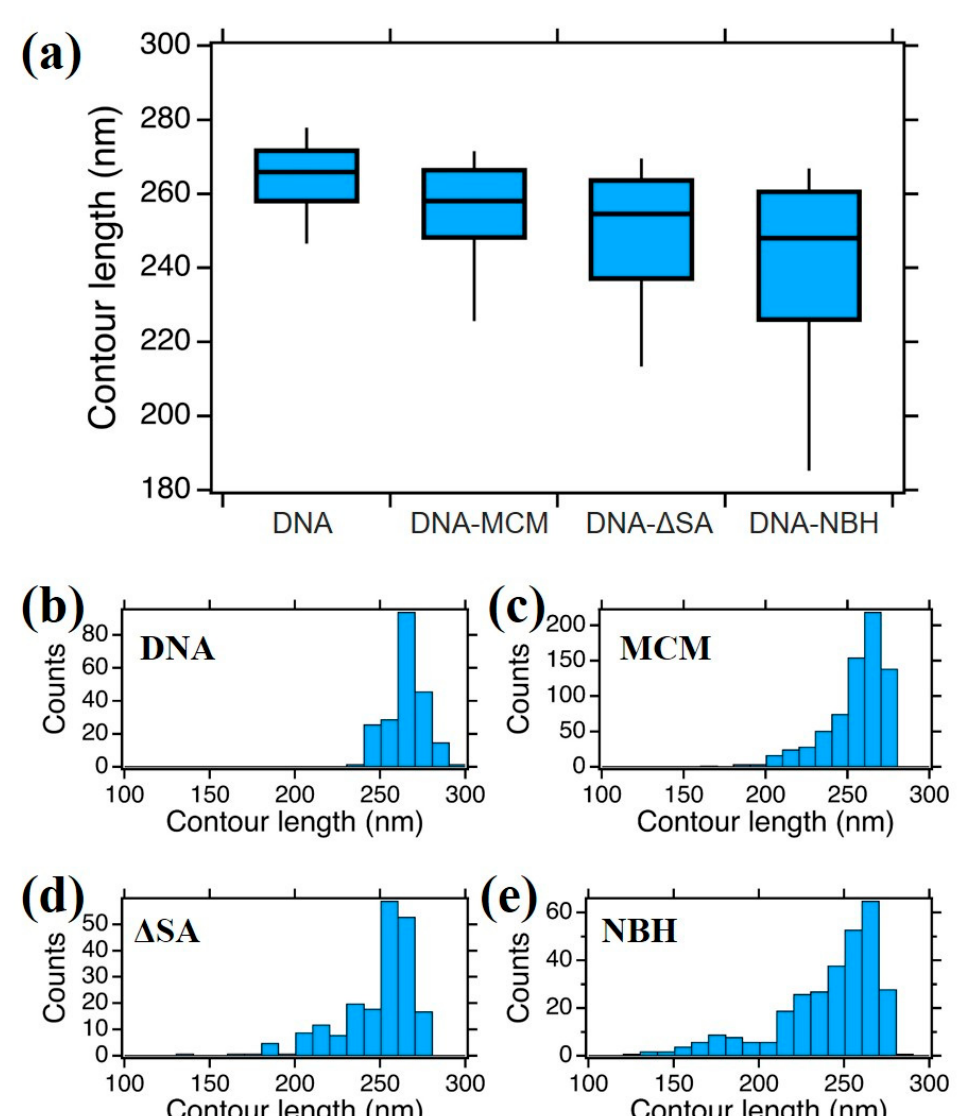
Figure 5. ( a ) Boxplot analysis of DNA contour length of bare DNA, MCM–DNA, ∆ sA–DNA, and NBH–DNA complexes; ( b – e ) the histograms show the 807 bp DNA contour length distributions of DNA alone ( b ) and protein–DNA complexes ( c – e ), constructed with bin size of 10 nm. The distributions are statistically different, with p < 0.001 (non parametric Matt–Whitney test).